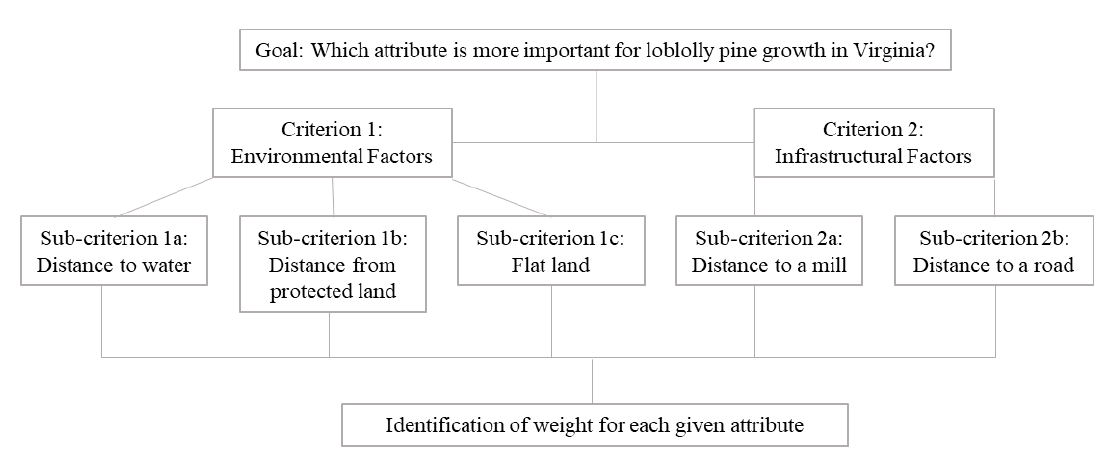
Figure 1. Analytical hierarchy process general framework (adapted from Saaty, 1980).